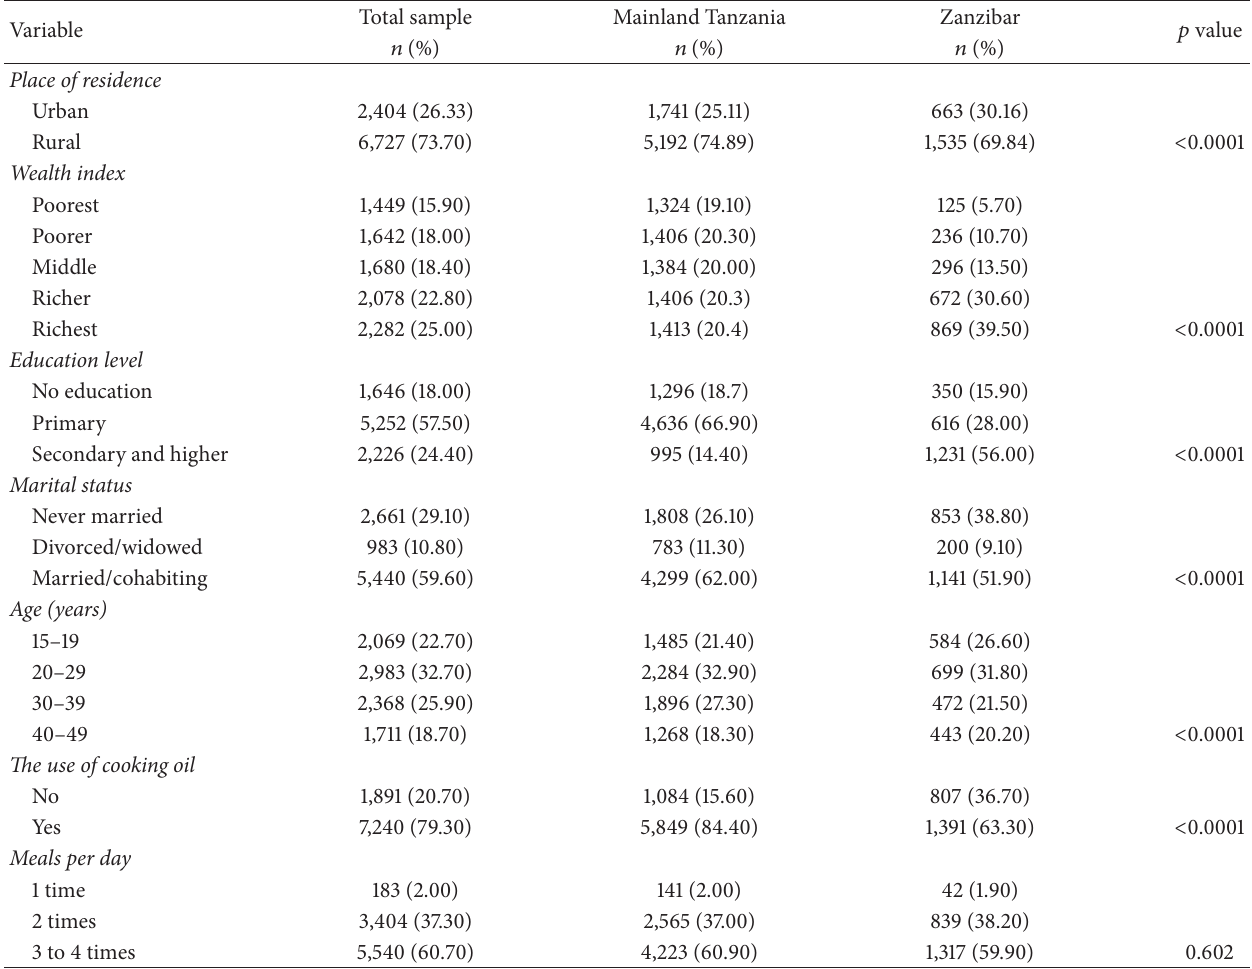
Table 1: Baseline characteristics of the 9131 nonpregnant women surveyed in Mainland Tanzania and